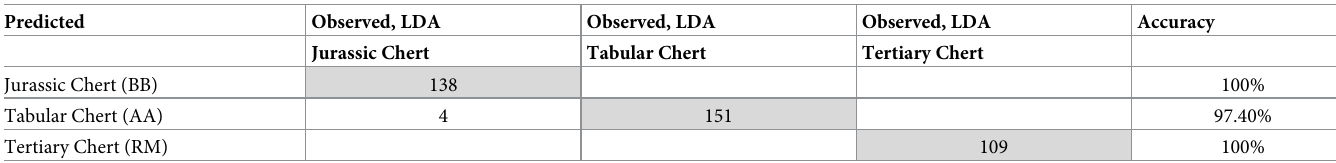
Table 2. LDA predictions (discriminant-scores) of the geological samples.